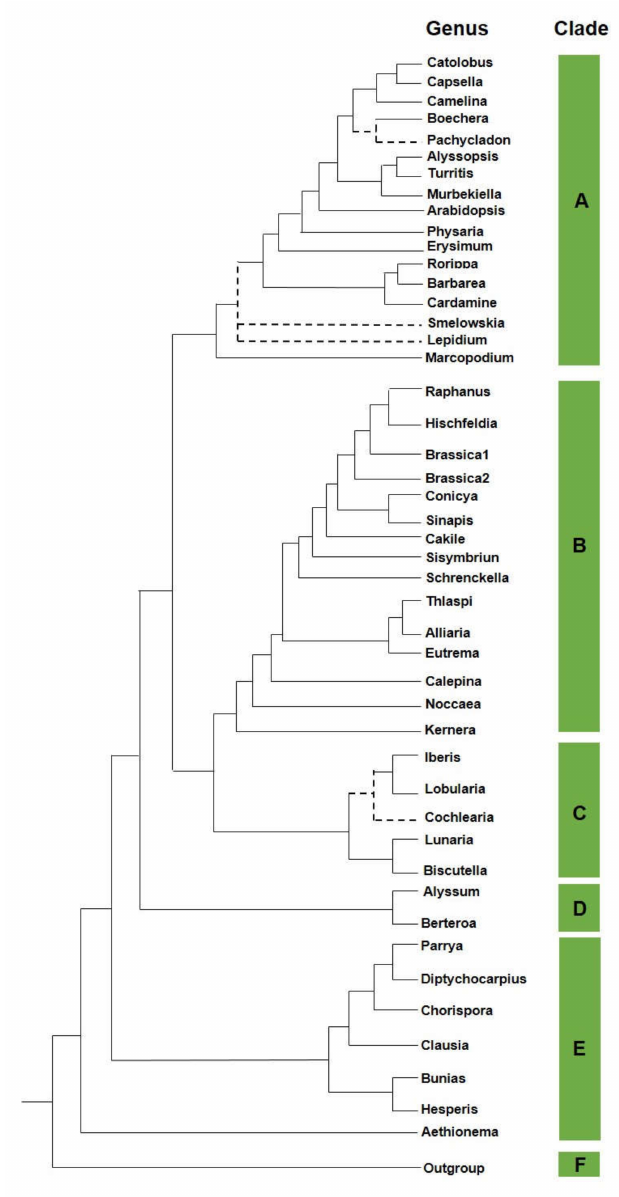
Figure 1. Phylogeny in Brassicaceae. A schematic phylogenetic relationship in the Brassicaceae